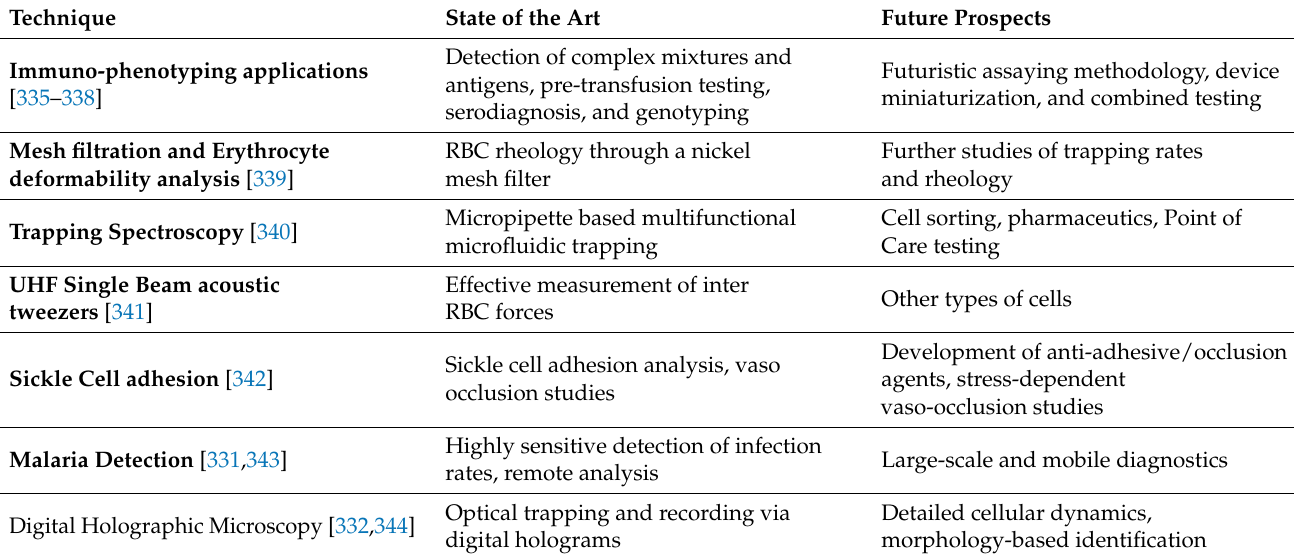
Table 4. Microarray-based Single RBC Manipulation